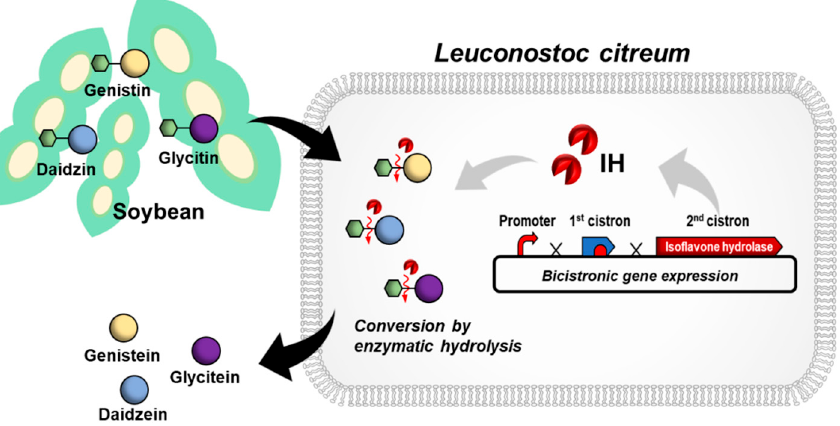
Figure 1. Schematic of L. citreum engineering for the efficient bioconversion of soy isoflavone glycoside forms to aglycone forms.